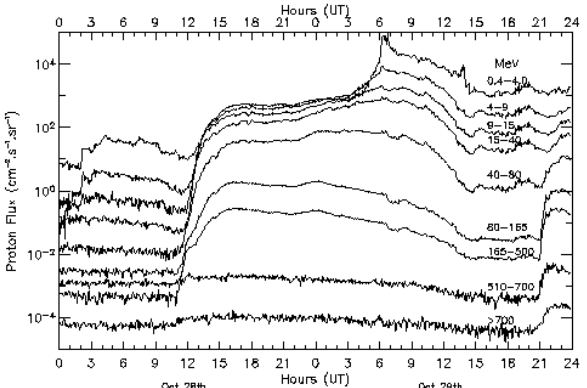
Fig. 2. Proton fluxes in 9 energy bands, GOES-11, 28–29 October 2003.